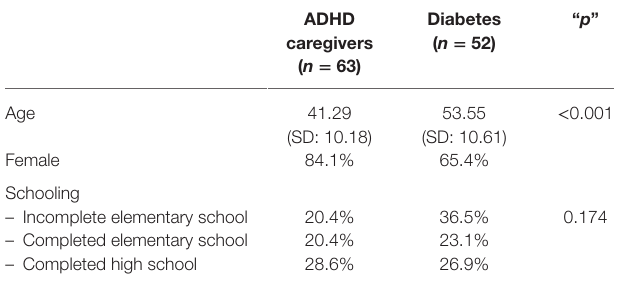
TaBle 1 | sociodemographic characteristics of aDhD caregivers and diabetes